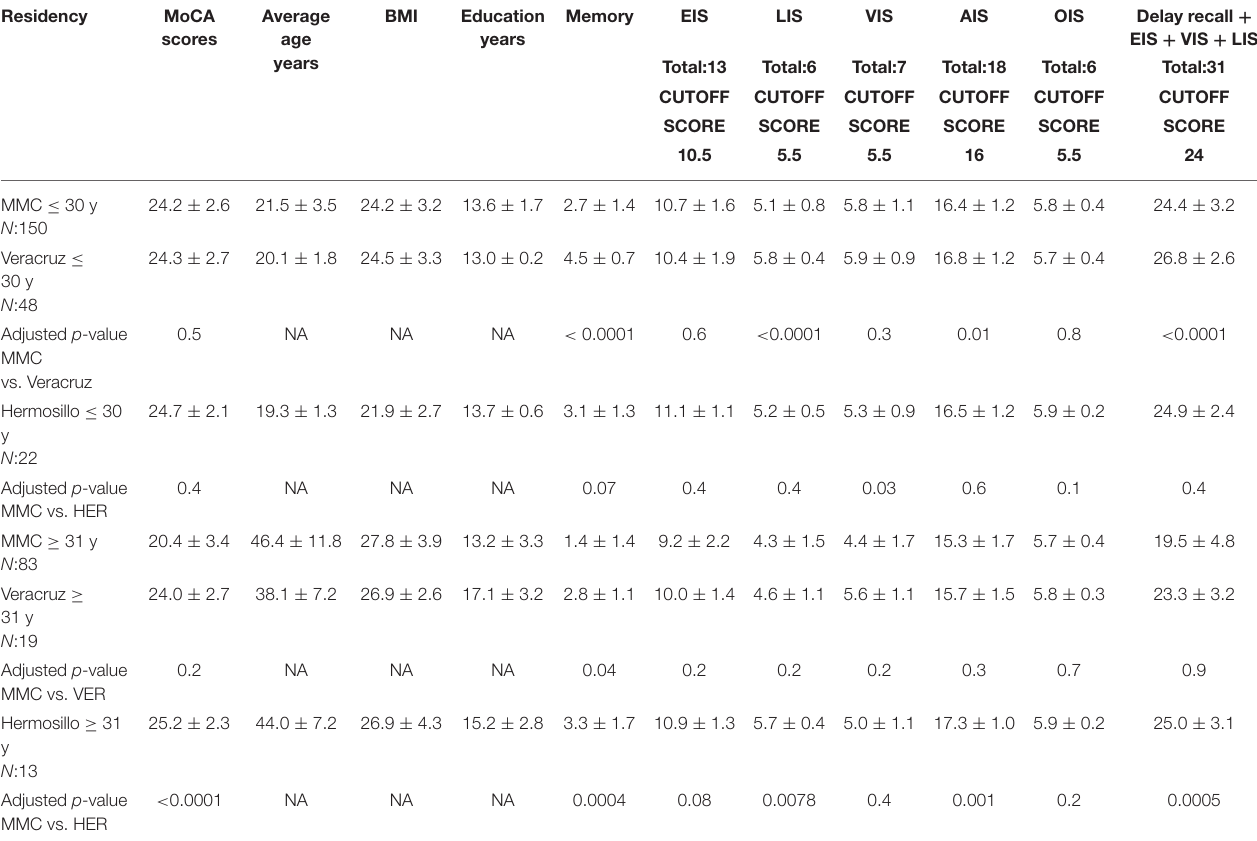
TABLE 2 | Summary of MoCA scores, age, BMI, education years, and cognitive domain scores. Residency